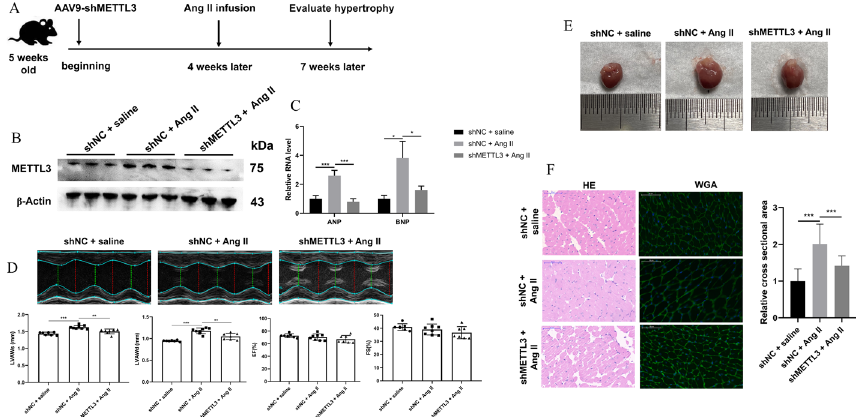
of animal research. B Western blot detected the expression of METTL3 in AAV9-shMETTL3 transfected with mice infused with Ang-II. n 3. C qRT-PCR detected the expression of biomarkers, including ANP and BNP, = in the heart of the three groups.